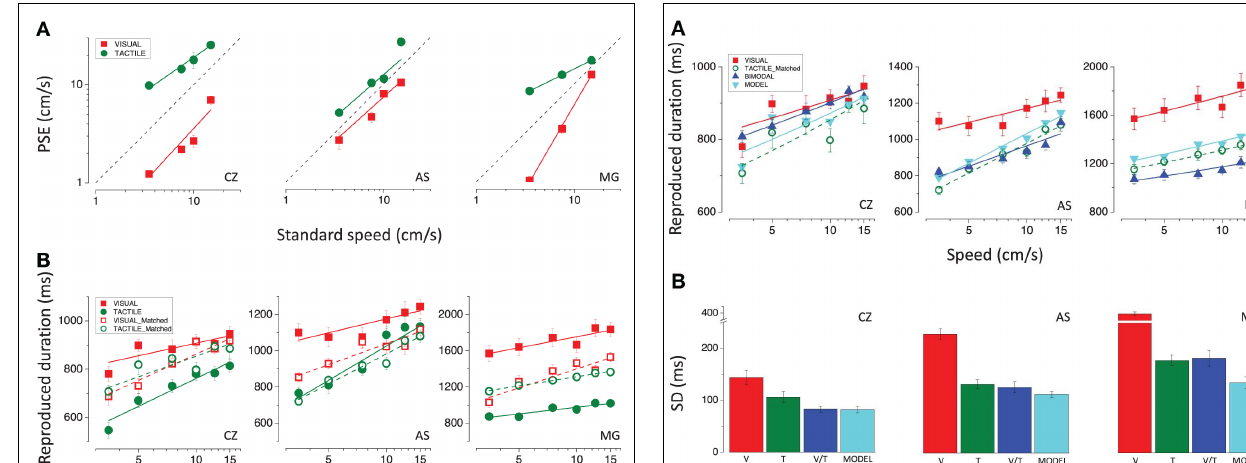
subjectsoutof three(CZandMG)perceivedspeedexplainsexactly